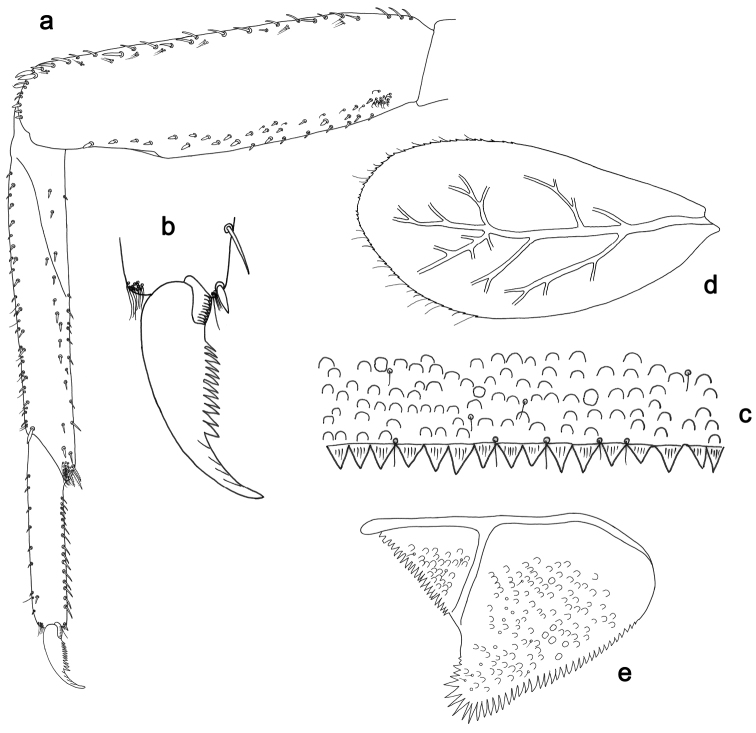
Labiobaetisstagnum sp. n., larva morphology: aForelegb Fore claw cTergum IV d Gill IV eParaproct.